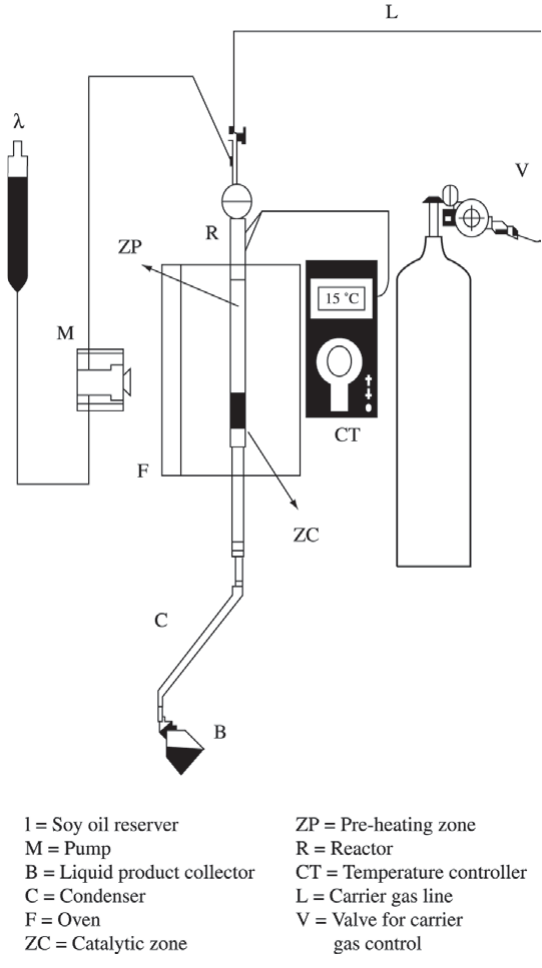
Figure 1. Scheme of the catalytic